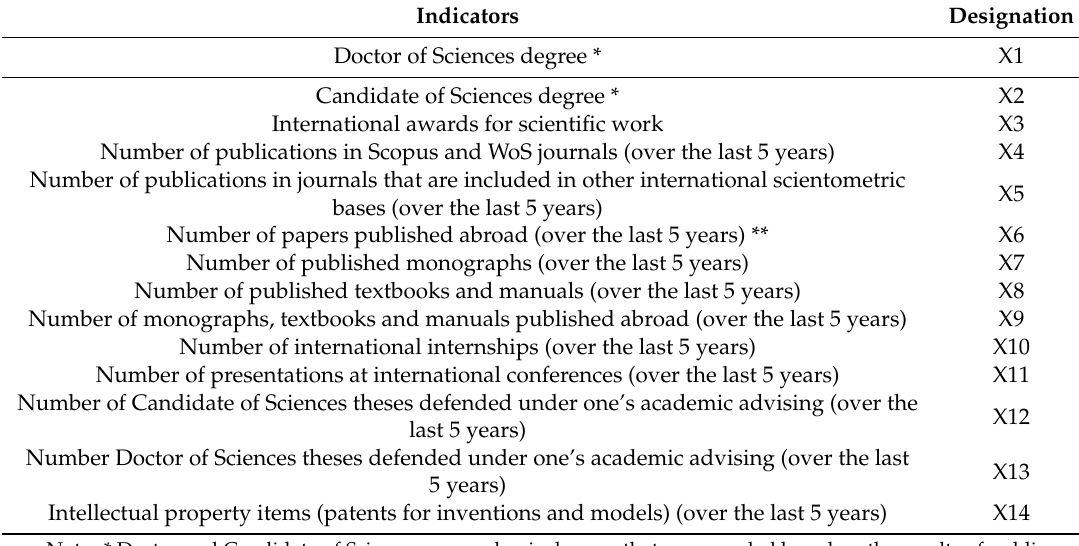
Table 2. The indicators of the productivity of scientific activity in the higher education system.